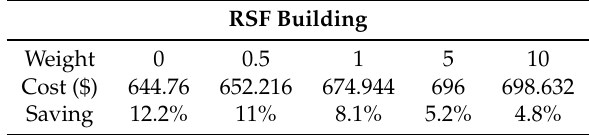
Table 3. Energy cost and saving for different weights of thermal comfort.